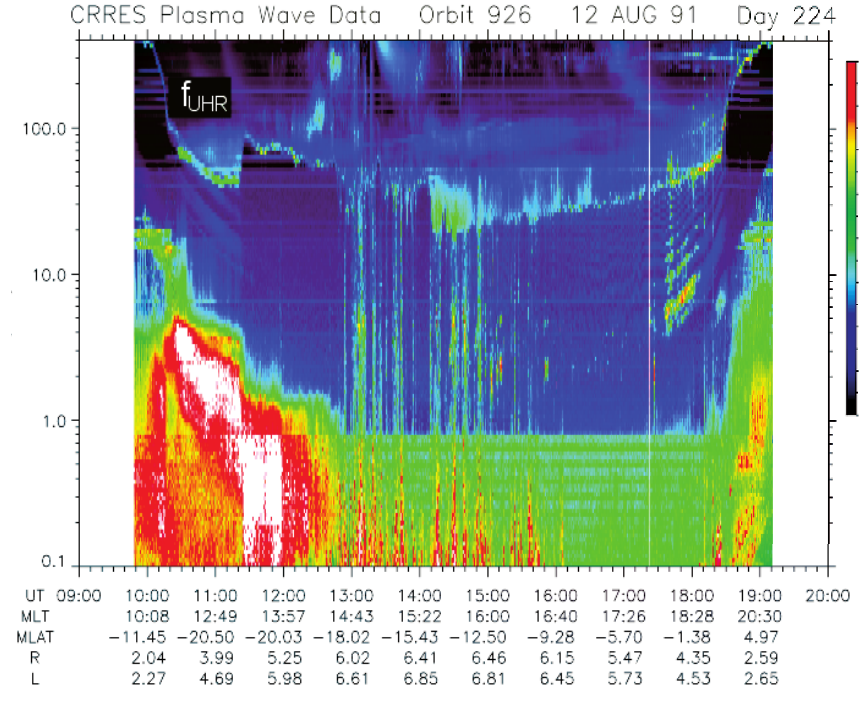
Fig. 2. Orbit 926, 12 August 1991 plasma waves spectrogram. The f UHR is indicated, which estimates the plasmapause location.